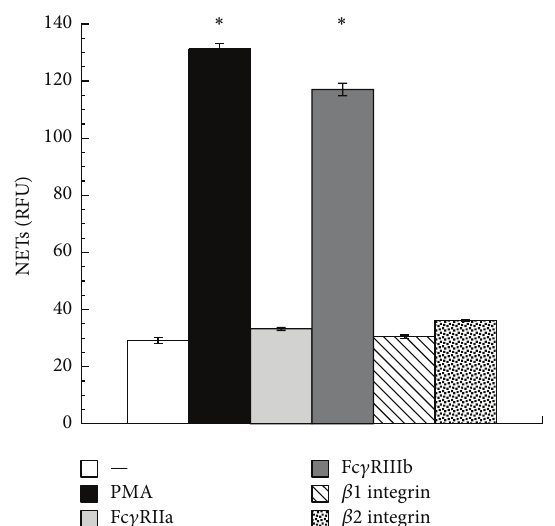
Figure 2: NETs are induced by PMA and Fc 𝛾 RIIIb cross-linking. Human neutrophils (PMN) were left untreated (—) or were stimu- lated with 20 nM phorbol 12-myristate 13-acetate (PMA), by cross- linking Fc 𝛾 RIIa with mAb IV.3, by cross-linking Fc 𝛾 RIIIb with mAb 3G8, by cross-linking 𝛽 1 integrins with mAb TS2/16, or by cross- linking 𝛽 2 integrins with mAb IB4. The relative amount of NETs, as extracellular DNA of nonfixed cells, was estimated from SYTOX Green fluorescence in relative fluorescent units (RFU) at 4 hours after stimulation, as described in Materials and Methods. Data are mean ± SEM of 4 experiments. Asterisks denote conditions that are statistically different from control ( 𝑝 < 0.05